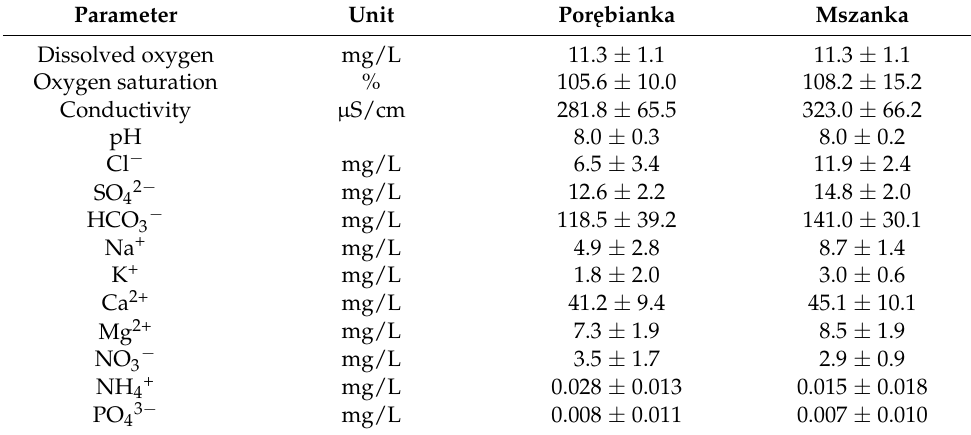
Table 2. The values of physicochemical parameters (mean, standard deviation) in the waters of the Por˛ebianka and Mszanka